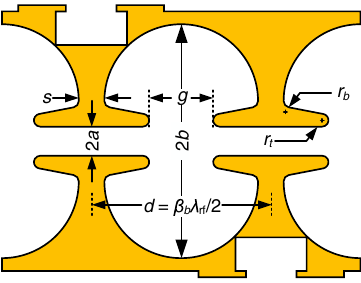
¼ 1 is the beam b